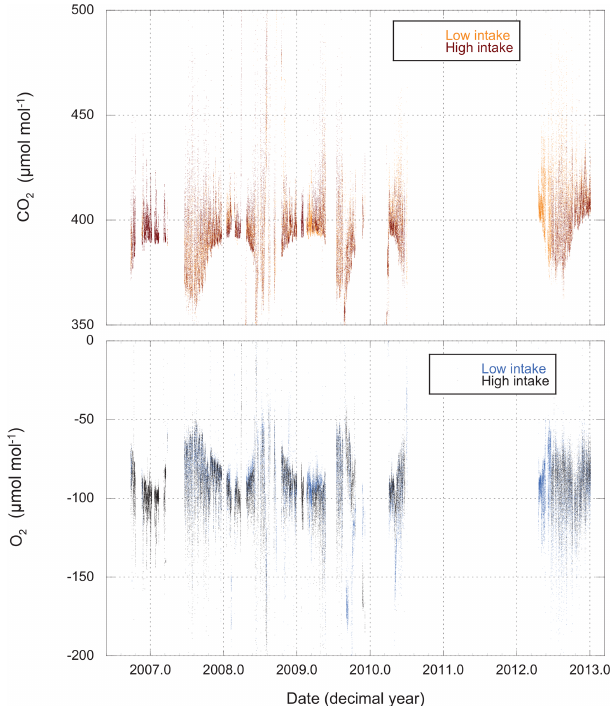
Figure 3. CO 2 and O 2 measured from both high and low intakes at Harvard Forest. The data have been processed (Sect. 2.2) and are presented on the WMO and S2 scales. Each point (spaced 11min apart) represents the average atmospheric composition for a 4.8min period.